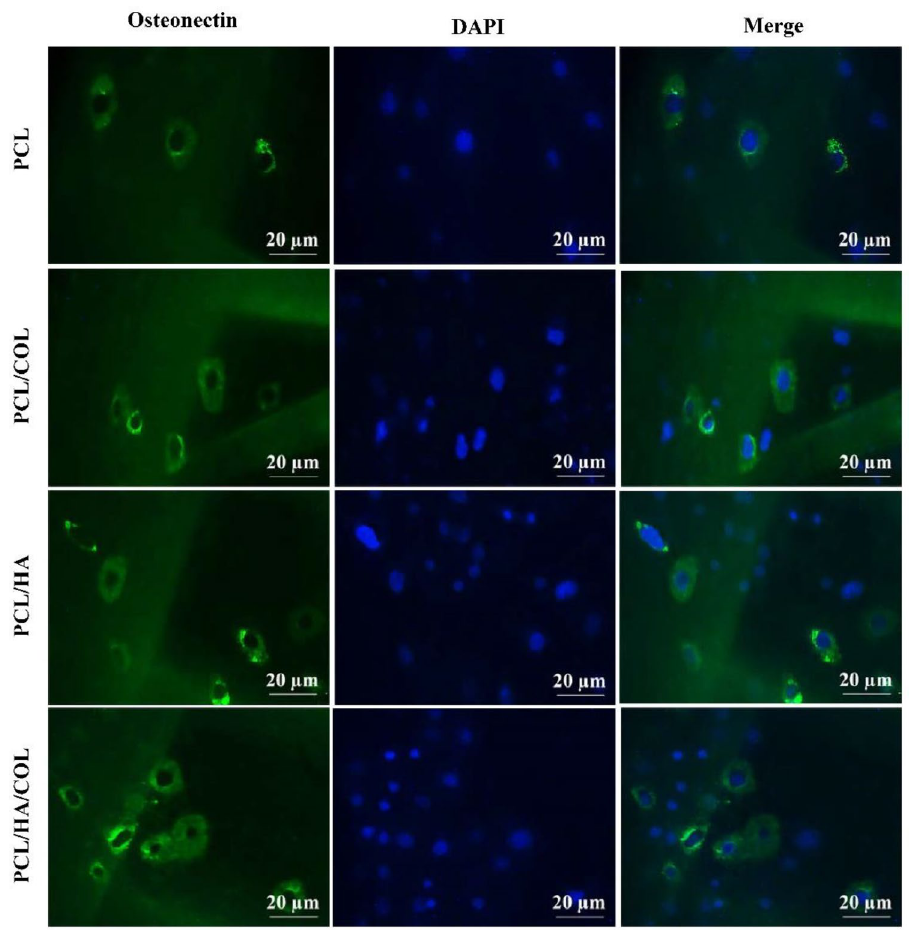
Figure 7. The expression pattern of osteogenic markers Osteonectin (first column), for hADSCs on PCL, PCL/ HA, PCL/COL and PCL/HA/COL scaffold after 21 days’ incubation in osteogenic medium determined by ICC assay. Cell nuclei in the images are stained with 4 ′ ,6- diamidino-2-phenylindole (DAPI) (Scale bar represents 20